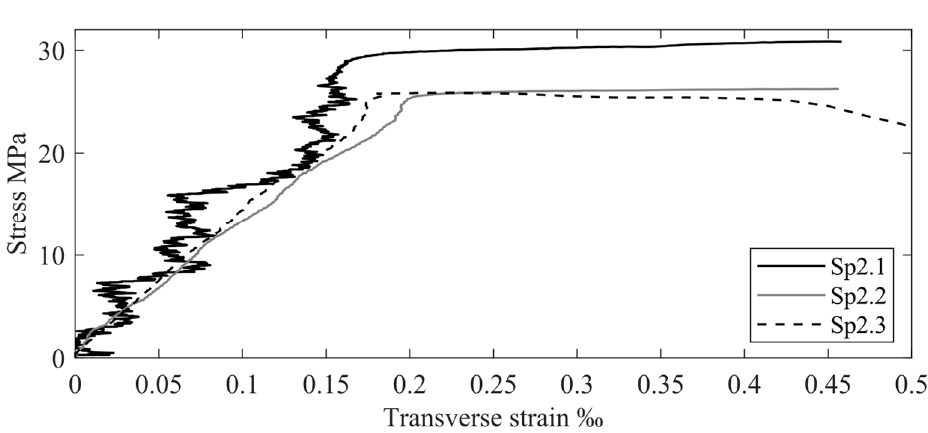
Figure 7. Experimental dependences σ c vs. ε trans